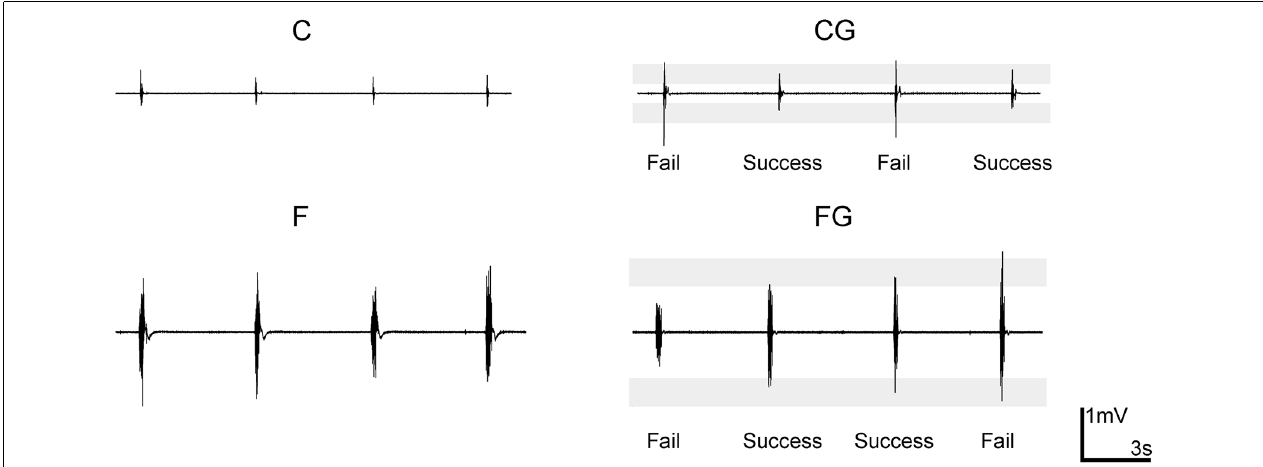
FIGURE 1 | Example recordings of electromyogram (EMG) level in motor tasks. Data from a representative subject (male, right-handed). The shading of two controlling tasks comfortable with a goal task and forceful with a goal task (CG and FG) indicates the target range. “Success” and “fail” indicate whether the muscle activity of that trial was inside the target